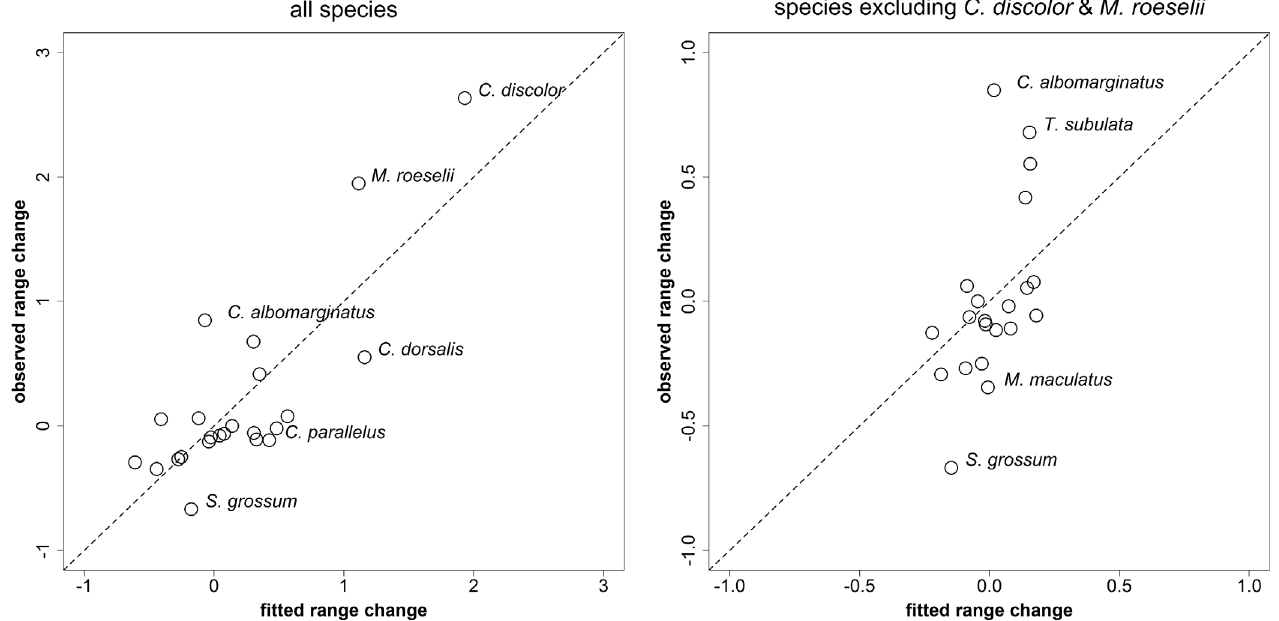
Fig 4. Observed vs. fitted range change values. Values for “ uncorrected range change ” , recording effort level 1. Fitted values are weighted means across the set of top GLM models with Δ AIC < 4. The dashed unity line indicates equality of observed and fitted values. Species with the largest residuals have been